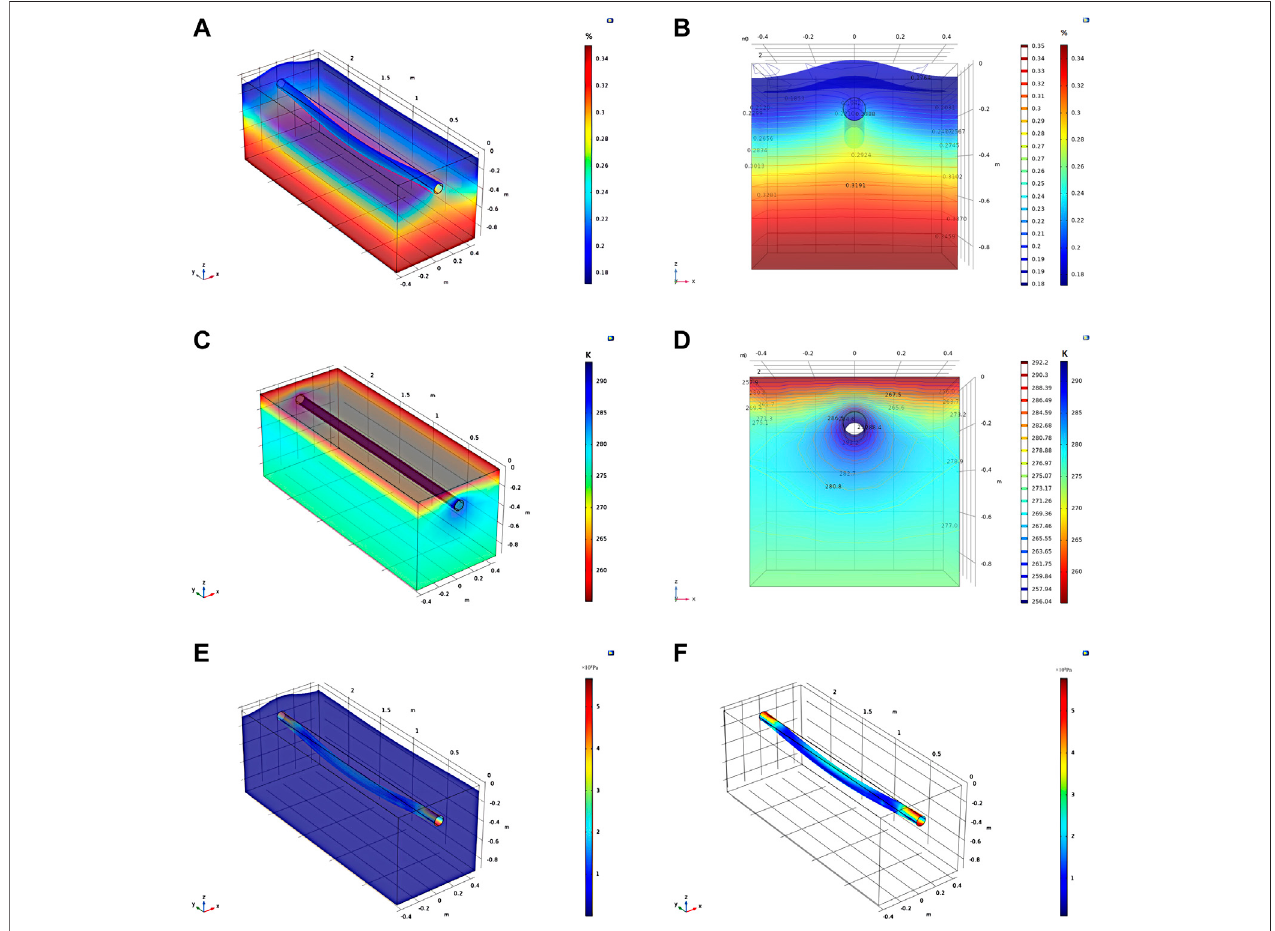
FIGURE 5 | Moisture, temperature, and pipe-soil stress fi elds under freeze-thaw cycles. (A) Moisture fi eld; (B) Moisture fi eld pro fi le; (C) Temperature fi eld; (D) Temperature pro fi le; (E) Pipe-soil stress fi eld; (F) Pipeline stress fi eld.